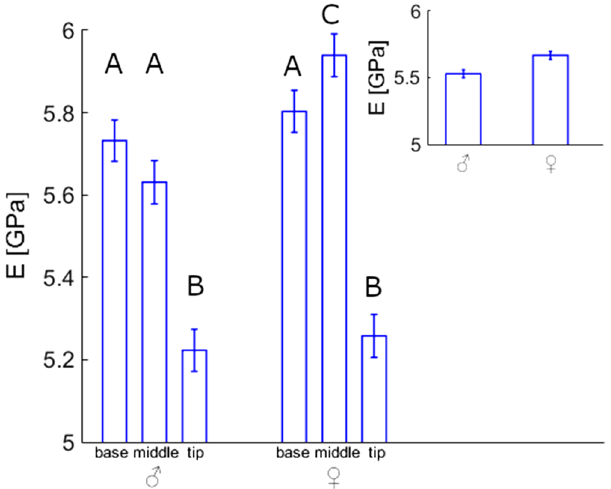
Figure 2. Effect of sex on Young’s modulus values of feathers. 32 feathers from 32 animals were used for the comparison. The number of individual measurements in the base, middle, and tip regions was 291, 266, 278 for males and 281, 271, 268 for females, correspondingly. Comparison between males (835 measurements) and females (820 measurements) is shown in